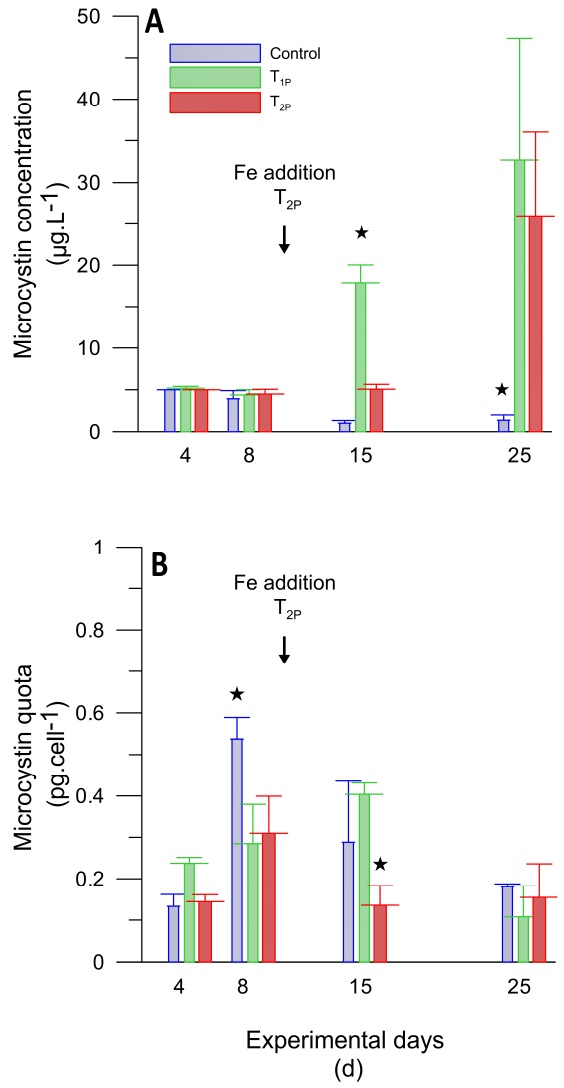
Figure 4. Microcystin (MC) concentration (µg·L −1 ) and MC quota (pg·cell −1 ) in Microcystis spp. natural populations from sample-2018 under the different treatment conditions during the second experiment. Control, without iron addition (179 ± 25 µg Fe·L −1 ); T 1P , with a single pulse: +700 µg Fe·L −1 at day 1 (D1); T 2P , the same amount divided in 2: +350 µg Fe·L −1 at D1 (first pulse) and 350 µg Fe·L −1 at day 9 (second pulse). Values are the means of triplicates, and vertical lines above bars are standard deviations. Asterisks are located above the treatments that showed a significant difference in the MC concentration ( A ) and MC quota ( B ) in comparison with those in the other treatment groups.